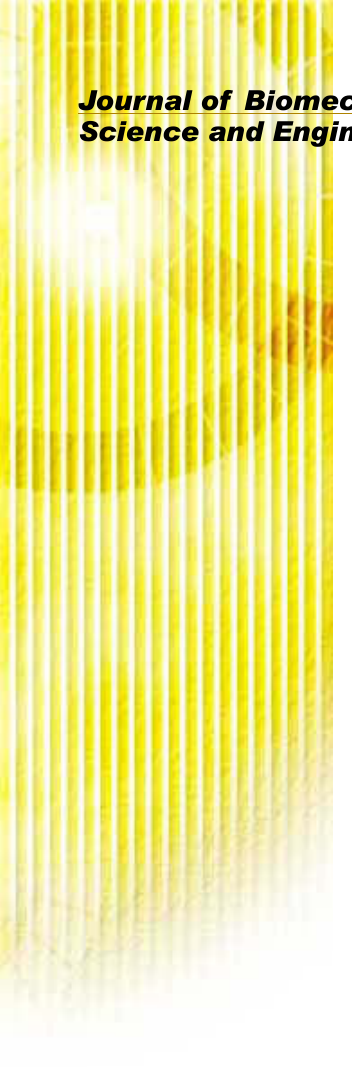
where d ( x , θ ) is the delay time at x, and v is the speed of sound in water. The measured waveform at angle θ is given by